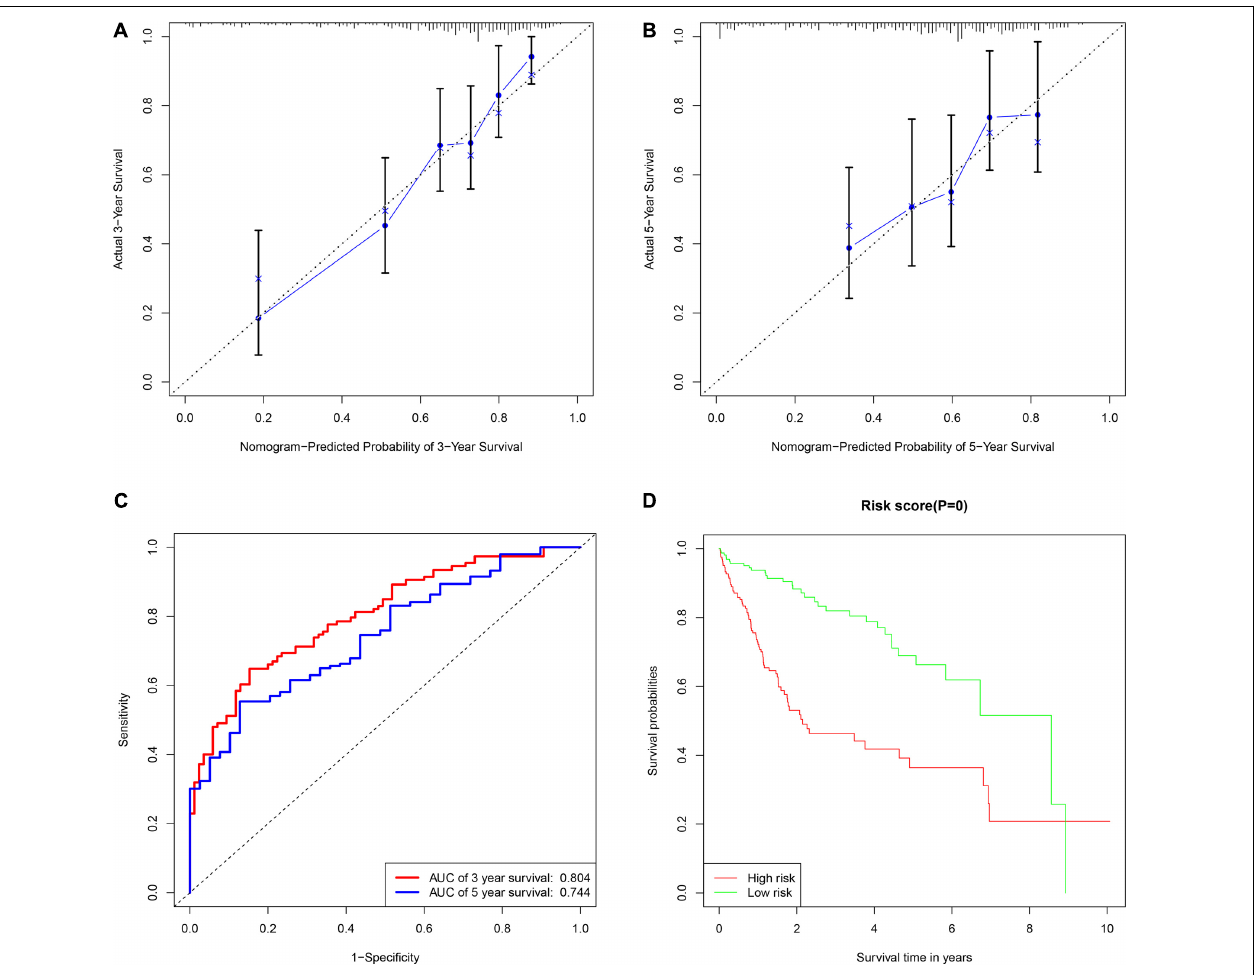
FIGURE 4 | The assessment of miRNAs-based clinical prediction model. The calibration curves according to nomogram model to estimate the survival rate at 3-year (A) and 5-year (B) , the X and Y -axis represent predicted and actual survival time respectively. The efficacy of prognostic model of 3- and 5-years survival rate based on time dependent receiver operated characteristic curves (C) . The Kaplan-Meier curve of overall survival time between the high- and low- risk groups stratified by the mean of total risk scores (D)